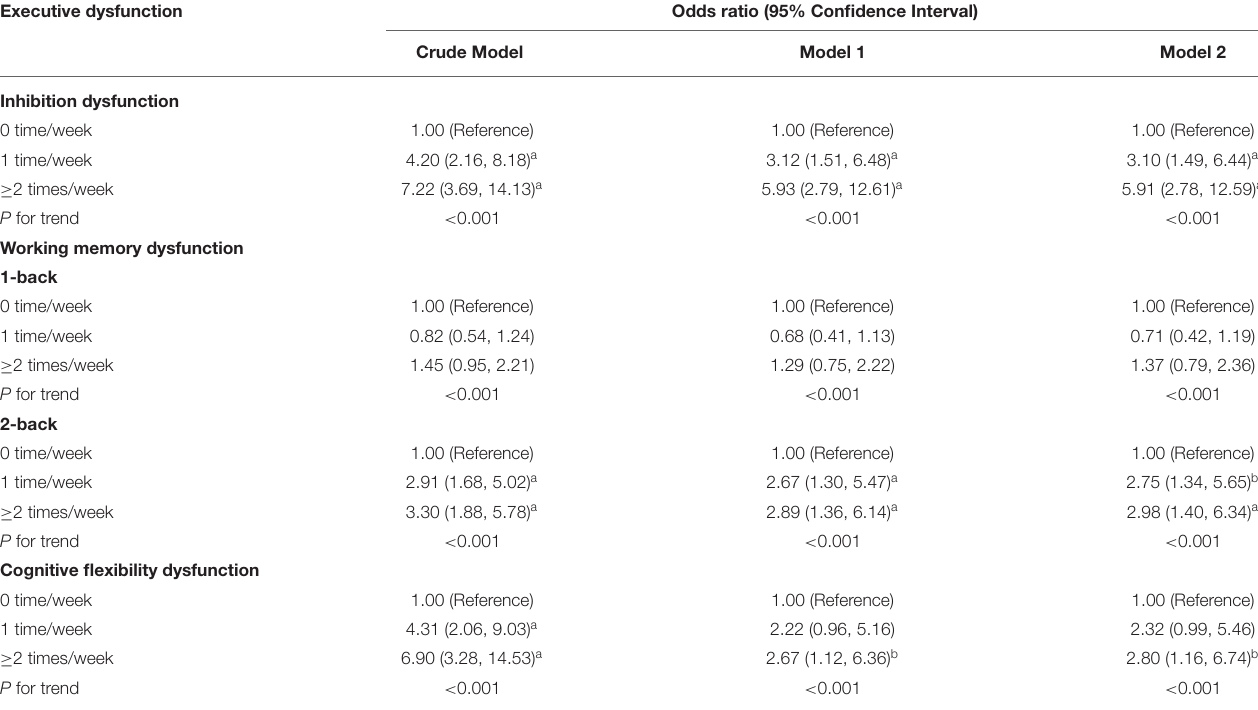
TABLE 4 | The logistic regression of executive function for Chinese Tibetan adolescents with different SSB consumption ( n =